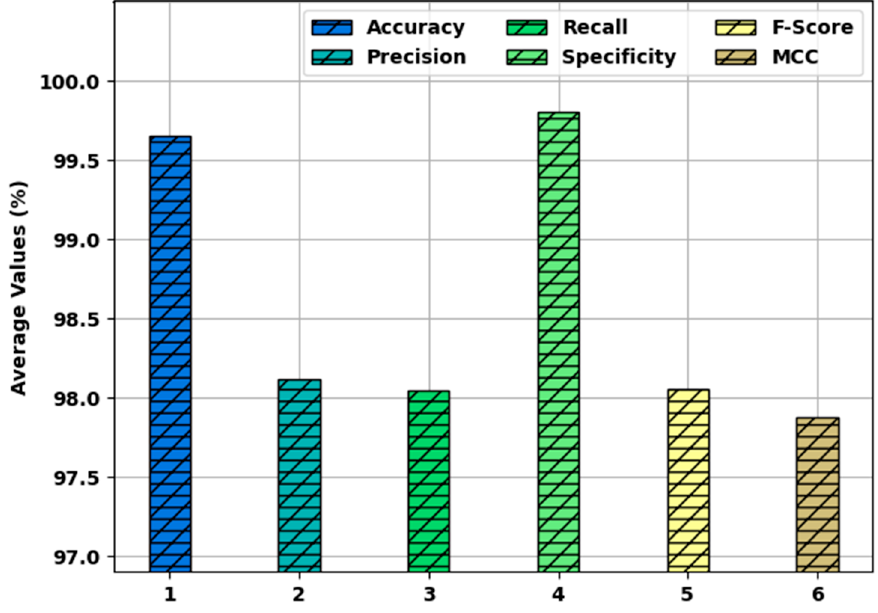
Figure 10. Average analysis of SFODLD-SAC technique on 30% of TSS.